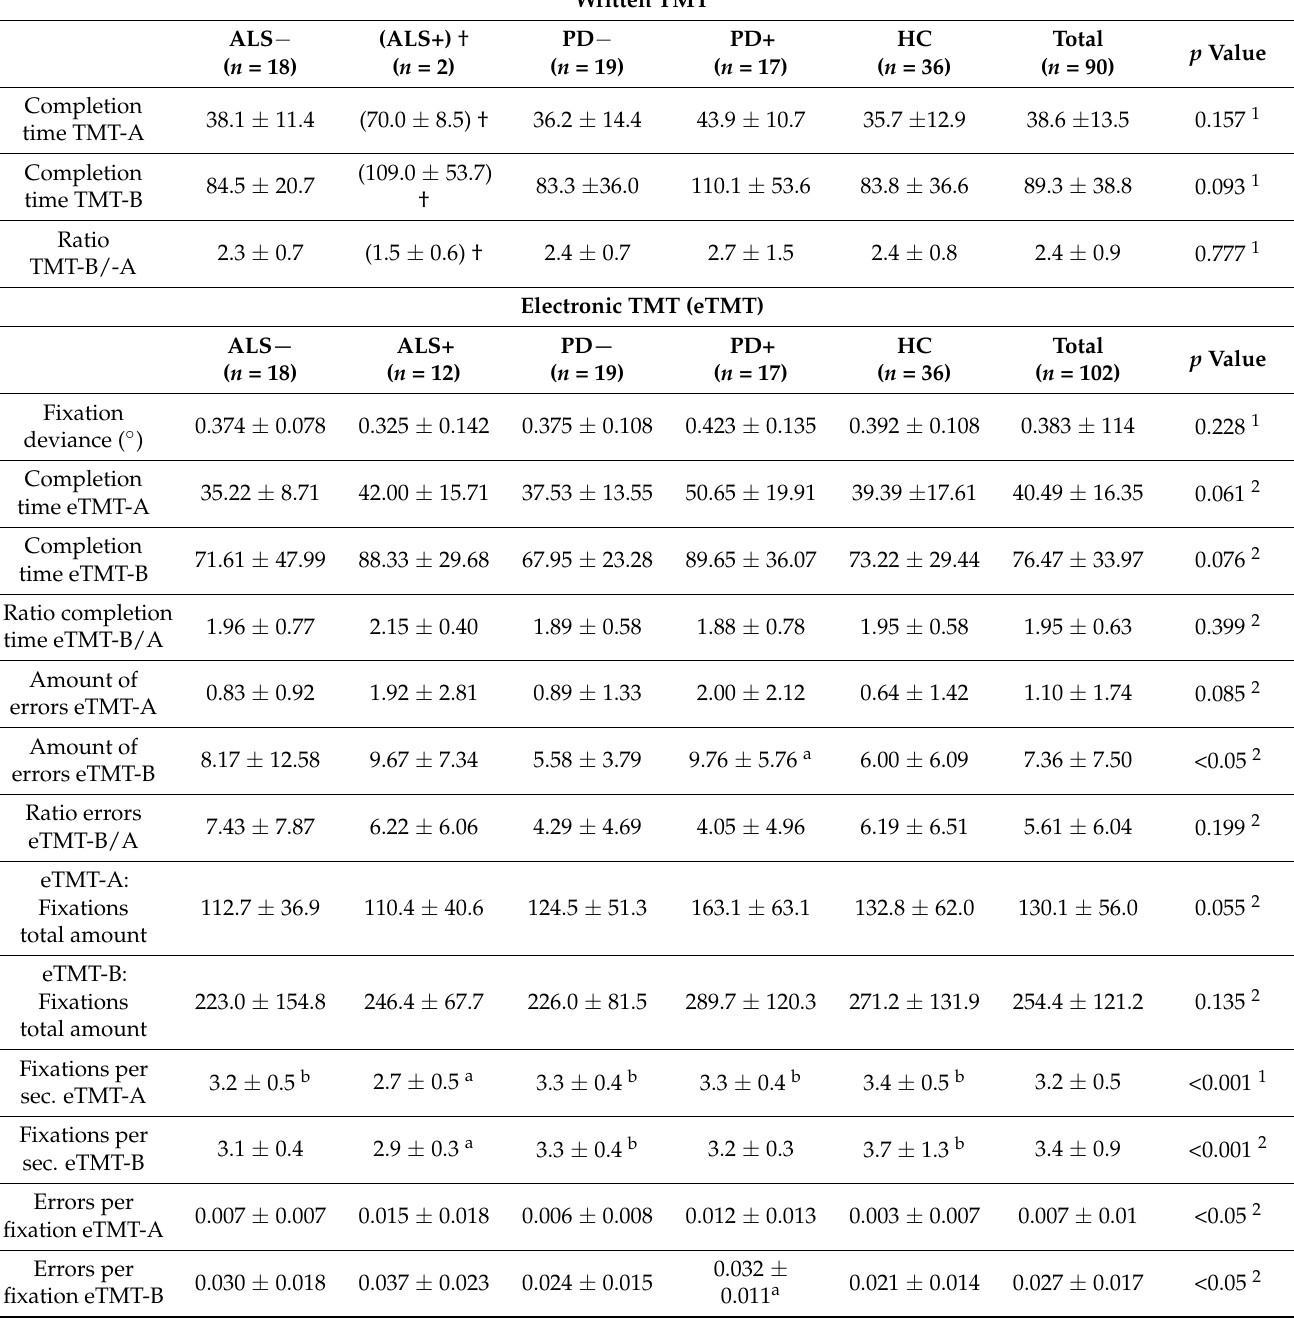
Table 2. Results for TMT and